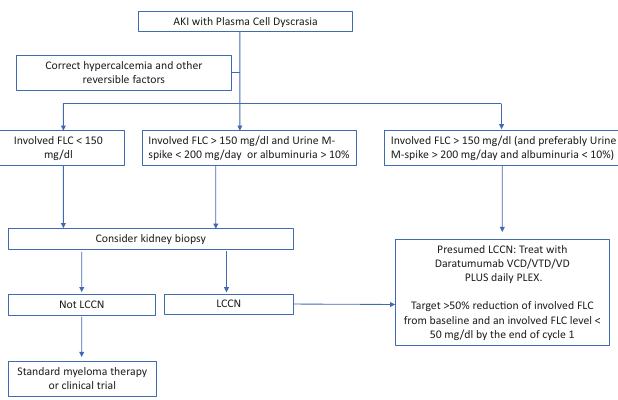
Fig. 1 Treatment algorithm for newly diagnosed multiple myeloma patients with acute kidney injury. AKI acute kidney injury, FLC free light chains, M monoclonal, LCCN light chain cast nephropathy, VCD bortezomib, cyclophosphamide, dexamethasone, VTD bortezomib, thalidomide, dexamethasone, PLEX plasma